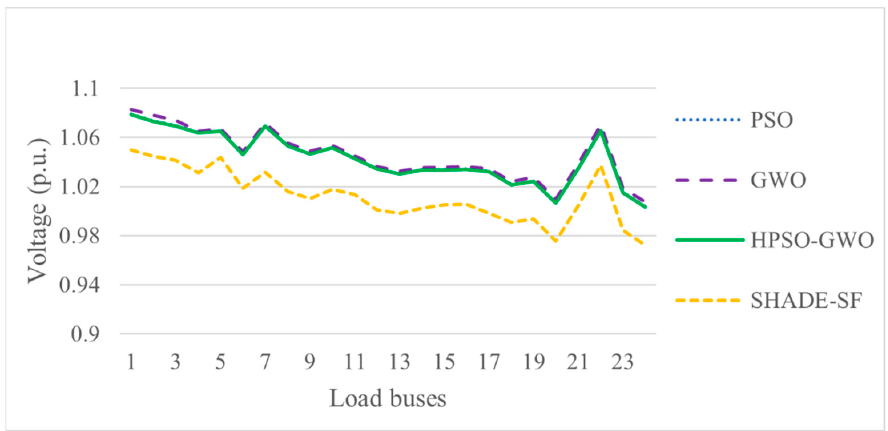
Figure 28. Generators reactive powers comparison (Case 5).